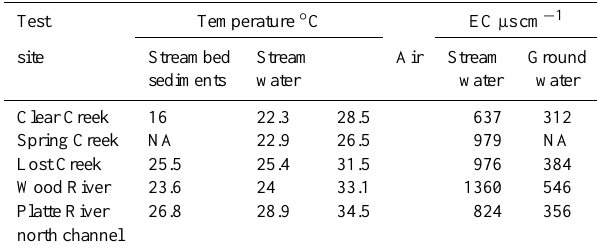
Table 2. Maximum, minimum, and median values of K v from the in situ permeameter tests.